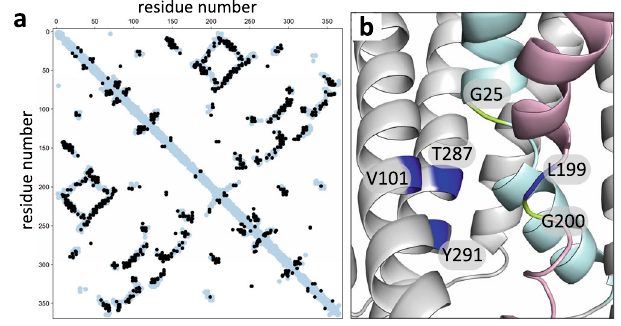
Fig. 1 GerAB resembles the L -alanine transporter GkApcT. a Interaction matrix comparing evolutionary coupled (EC) residue pairs in GerAB (black circles) with residue pairs that are ≤ 5 Å apart in the GerAB model (light blue circles) derived from the GkApcT structure. 51% of EC pairs were within 5 Å of each other in the GerAB homology model. b Predicted L -alanine binding pocket in GerAB. TM segments 1 (cyan) and 6 (pink) are highlighted. G25 and G200 that are predicted to generate discontinuities in these helices are shown in green. Residues predicted to line the L -alanine binding pocket are indicated in dark blue. A side-by-side comparison to the L -alanine binding pocket in GkApcT is shown in Supplementary Fig.